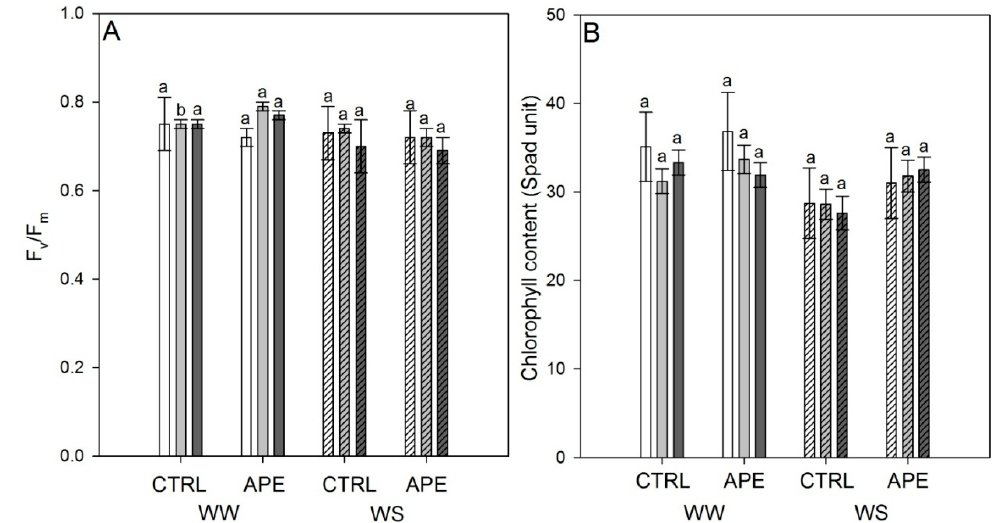
Figure 1. Maximum quantum yield of PSII (F v / F m ) ( A ) and chlorophyll content ( B ) of V. vinifera treated with A. platensis F&M-C256 extract (APE) and control plants (CTRL), under two water regimes (well-watered, WW; water-stressed, WS). Assessments were attended at t 0 (white columns), t 1 (light grey columns), and t 2 (dark grey columns). One-way ANOVA was performed on data (mean ± SE, n = 10). Within the same water regime and stage, different letters mean significant differences among APE and CTRL (LSD test, p ≤ 0.05).